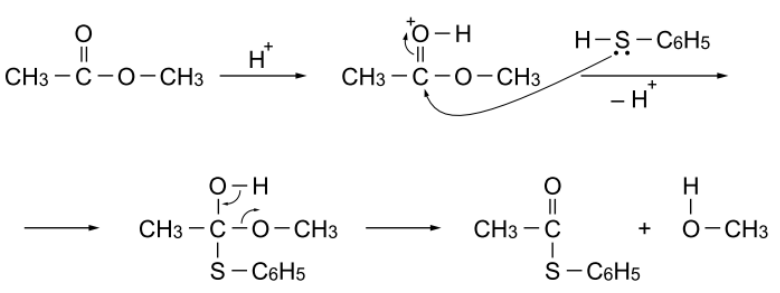
Cl )Cl (H O) ]·4H O/SiO . A mixture of benzenethiol (102 μL/h, 6 12 2 2 4 2 2